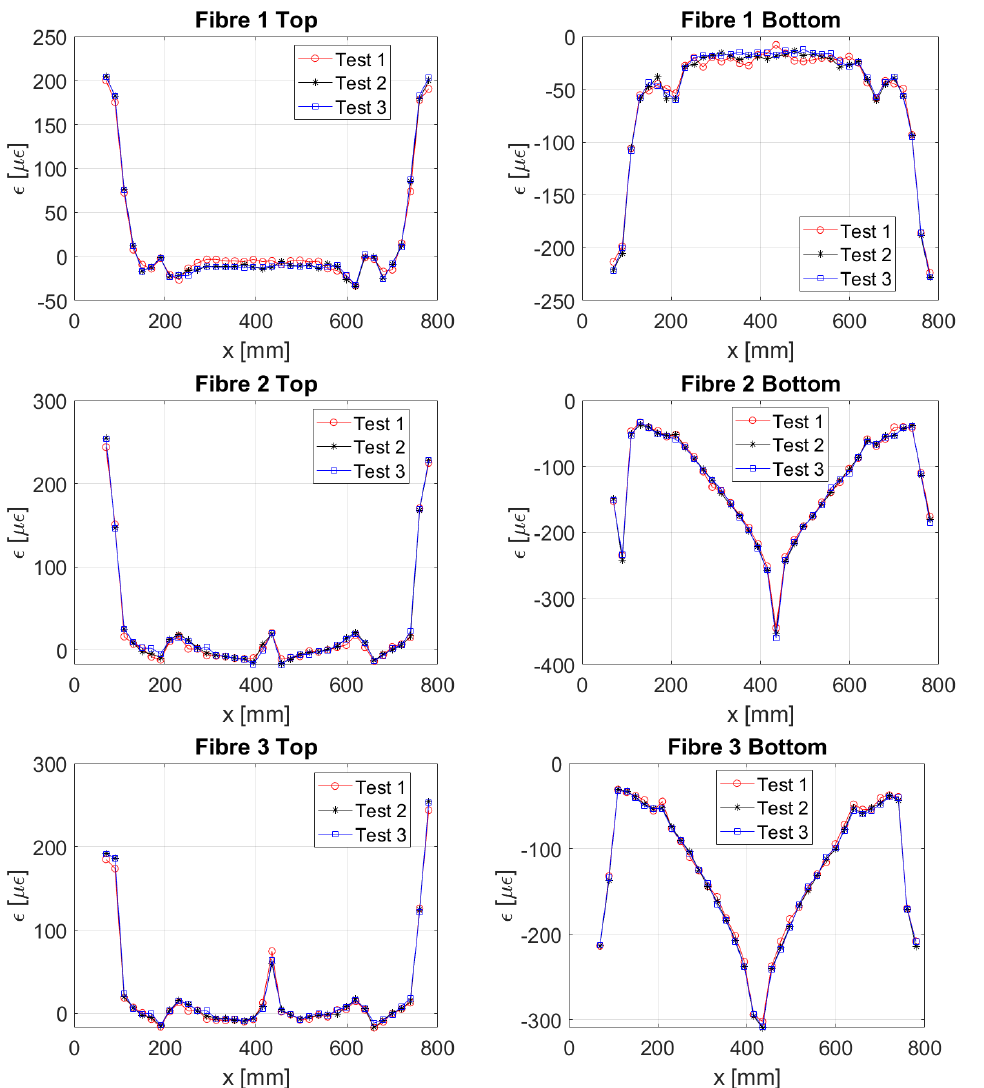
Figure A1. Experimental strains from the stiffened panel—The numbering of the fibres is the one reported in Figure